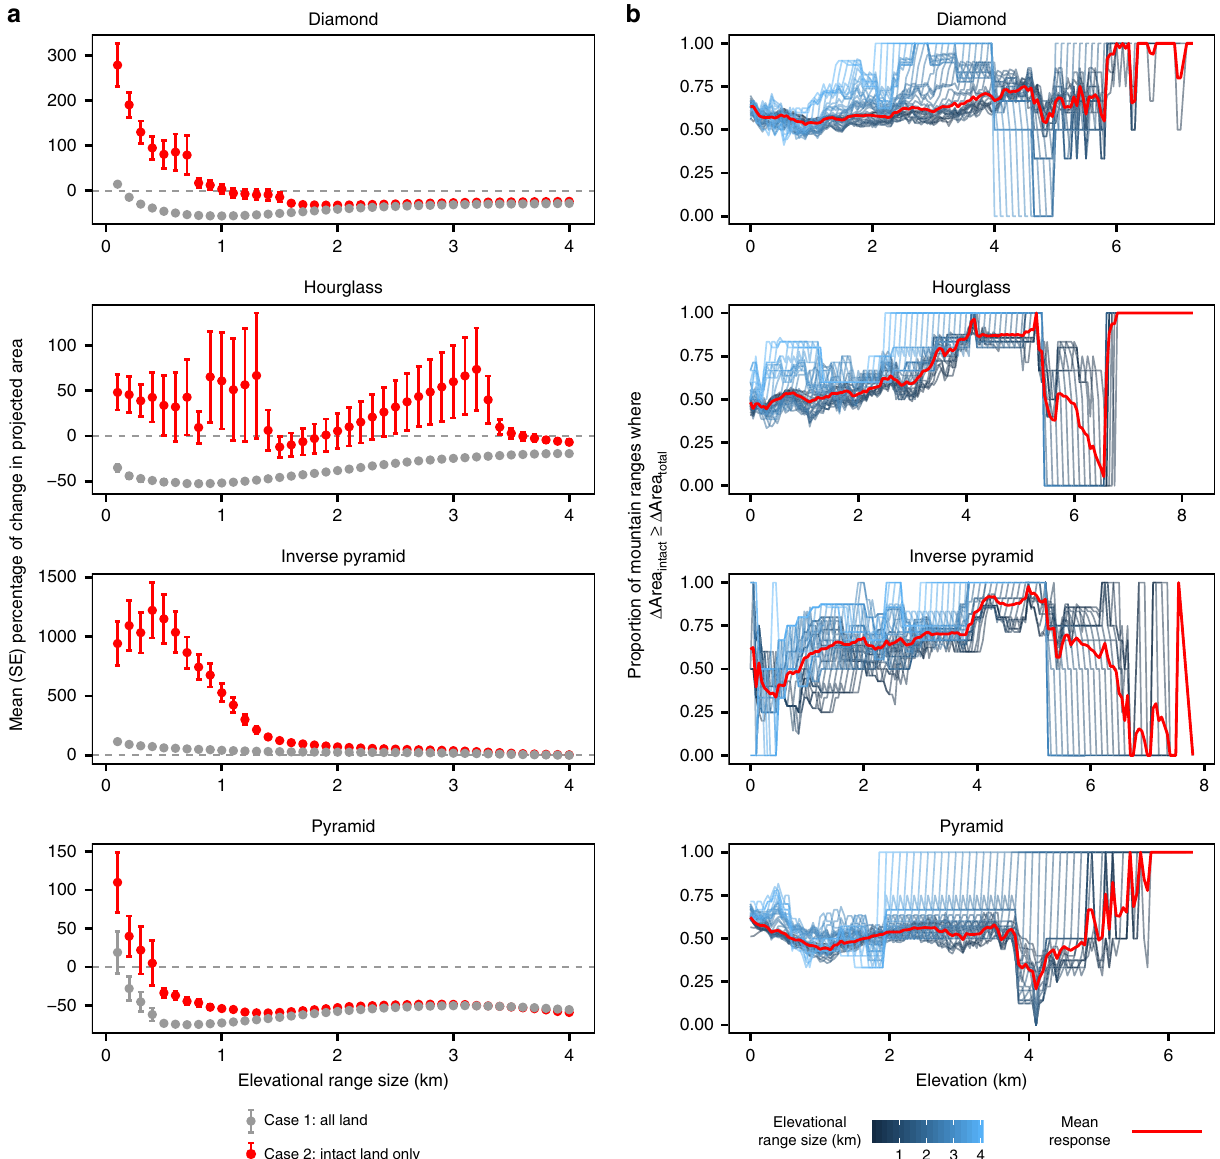
Fig. 4 The in fl uence of species ’ elevational range sizes on projected area changes following modeled elevational range shifts. a Mean and standard error percentage of change in projected total (gray) and intact (red) land area across all modeled species (within elevational range size classes, x -axis) and all mountain ranges by mountain classi fi cation. b Proportion of mountain ranges where percentage of change in intact land area equals or exceeds percentage of change in total land area following elevational range shifts across the elevational gradient by mountain classi fi cation. Blue lines indicate proportions for each elevational range size class considered in modeling (100 – 4000 m, in 100-m increments); red line indicates the mean response across all range class sizes. See text and “ Methods ” section for details of modeled range